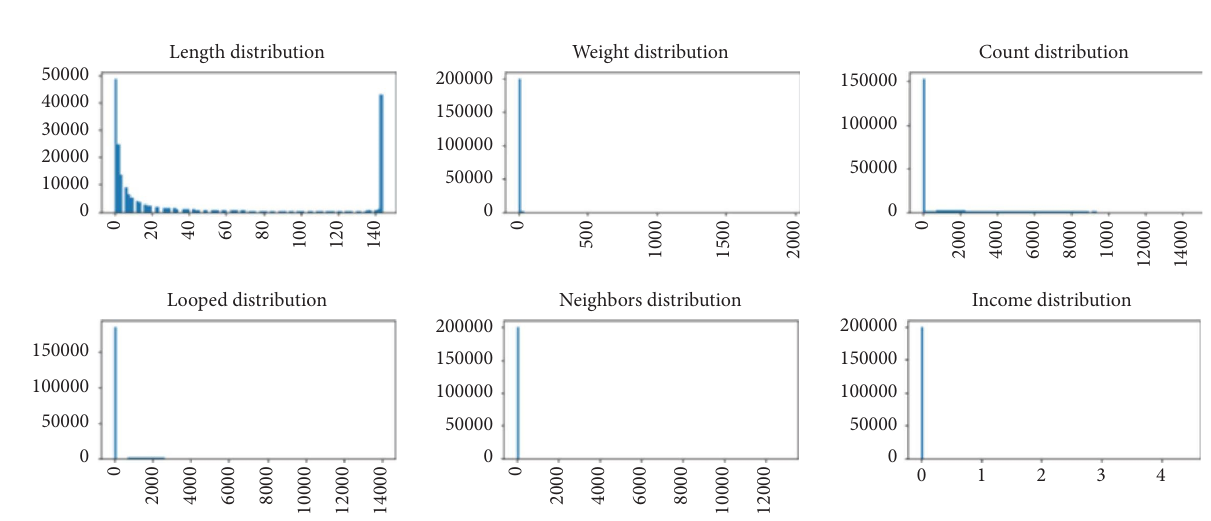
Figure 3: Attribute